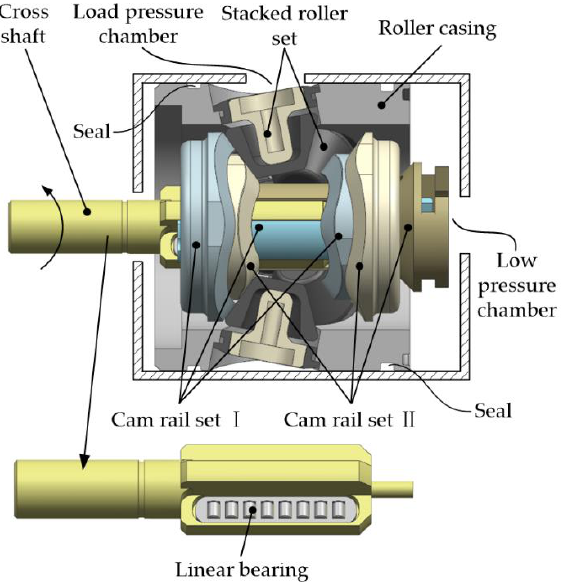
Figure 2. Structure of the high-speed transmission mechanism with a stacked roller set.